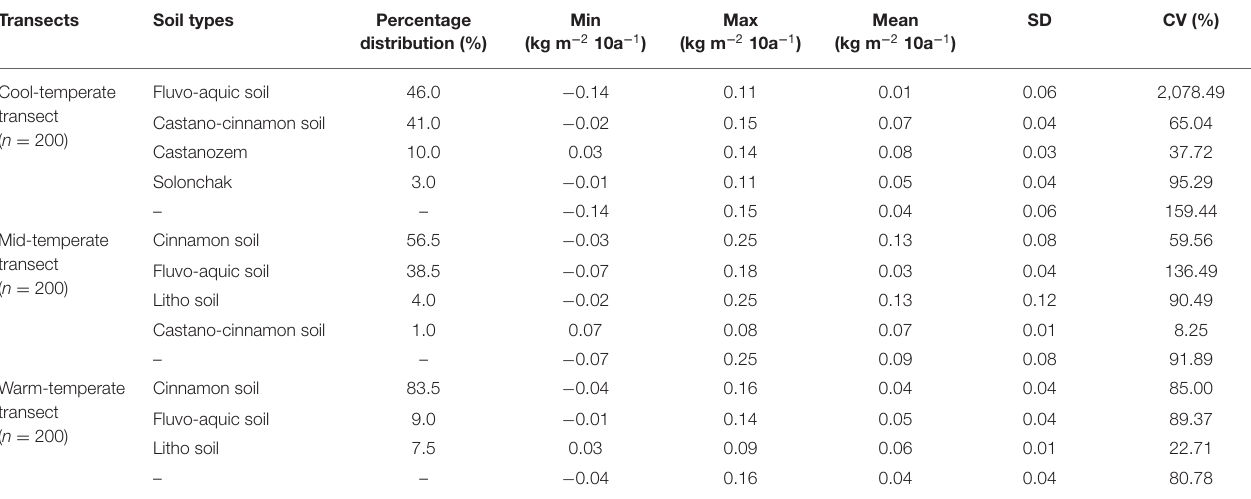
TABLE 1 | Comparison of temporal changes of soil nitrogen density (SND T ) under different soil types along the three transects.